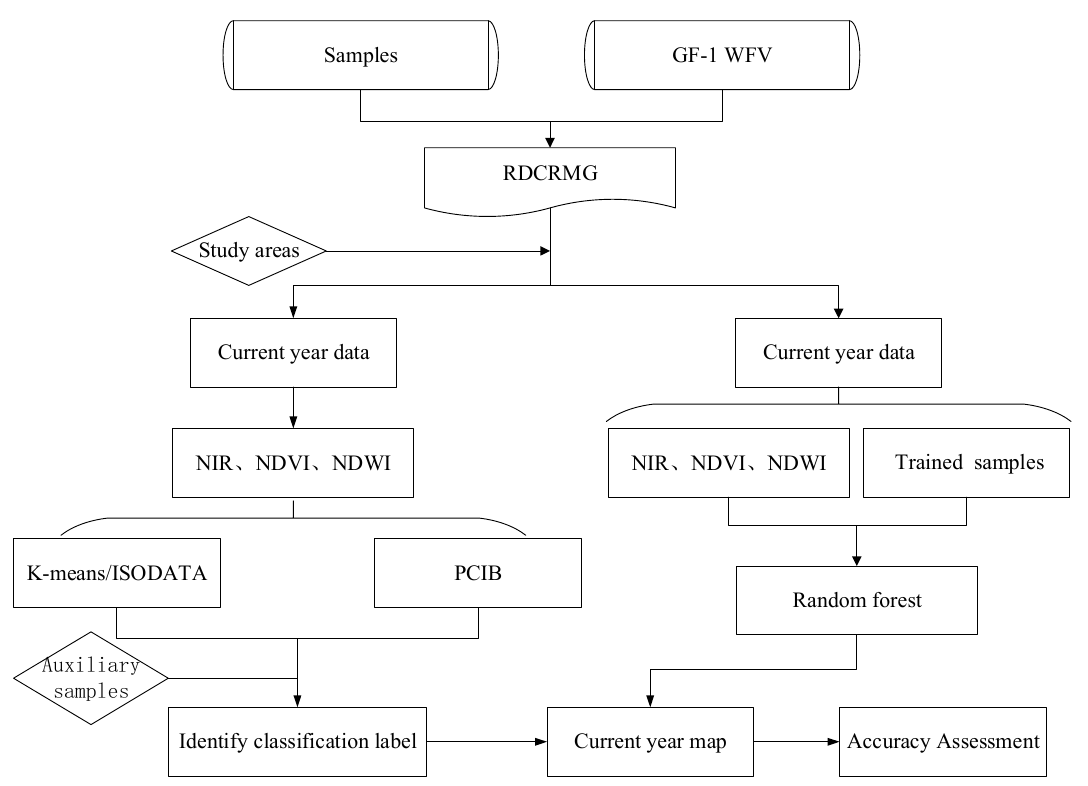
Figure 2. Workflow of the proposed approach, including five key steps: (1) data preprocessing; (2) feature value selection; (3) comparison of classification methods; (4) category label determination; (5) accuracy evaluation.